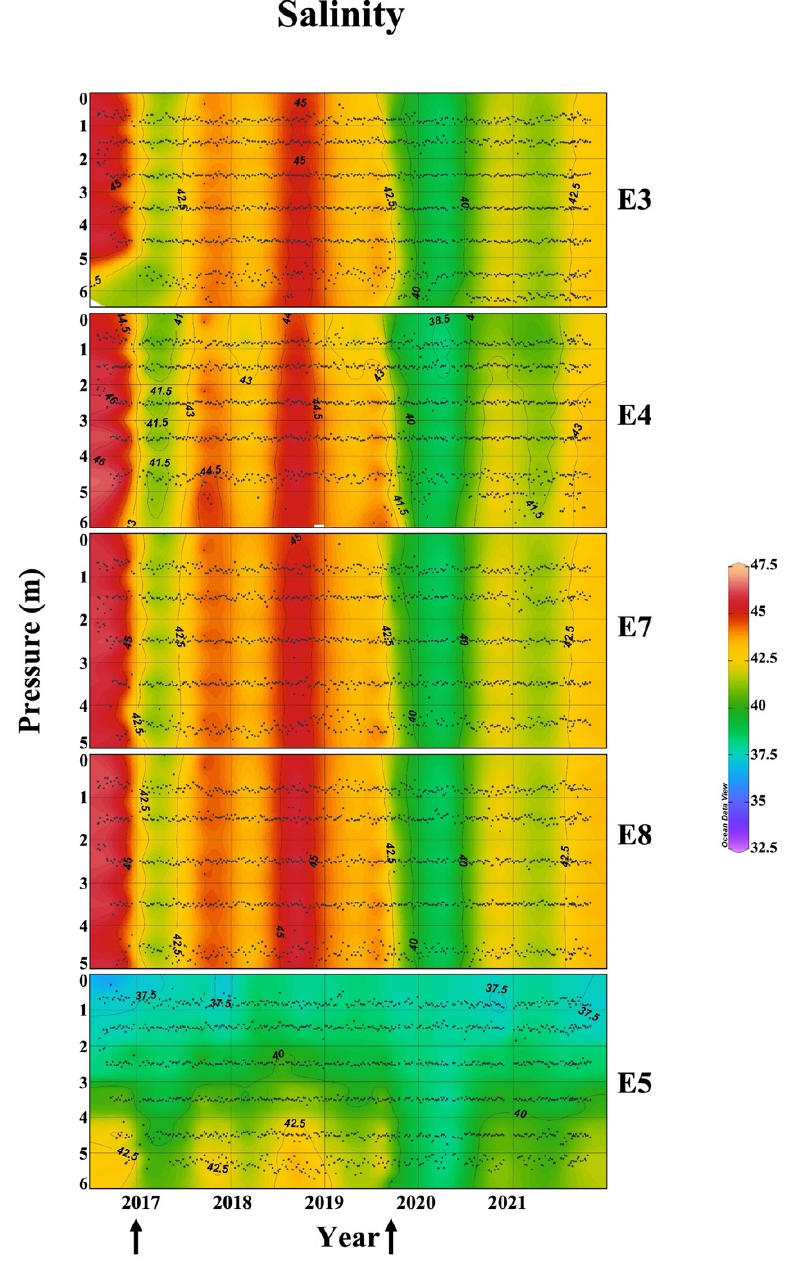
Figure 3. Temporal evolution of salinity at stations E3, E4, E7, E8, and E5 from August 2016 to October 2021. The vertical arrows indicate when the two DANA events occurred (December 2016 and September 2019, respectively).